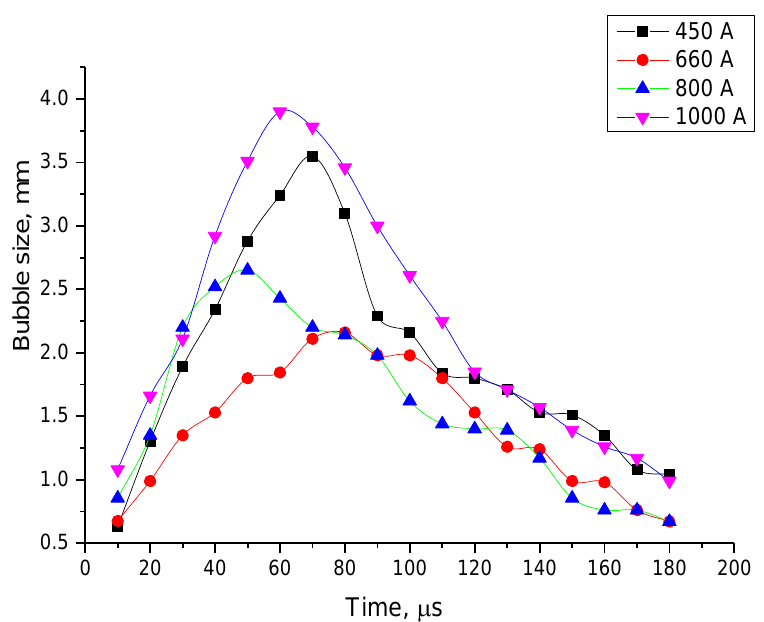
Figure 8. Time evolution of a bubble’s size for different values of maximal current.